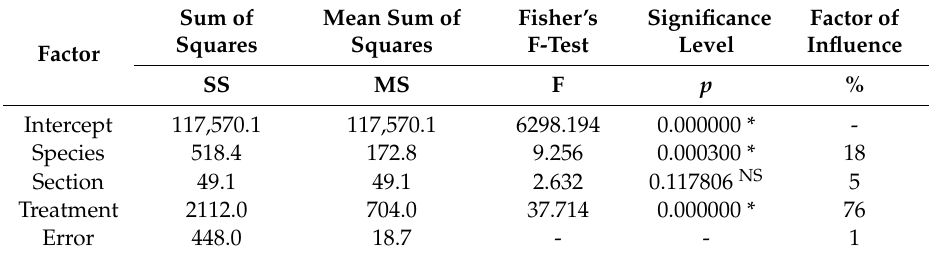
Table 6. Statistical evaluation of the factors influencing wood surface